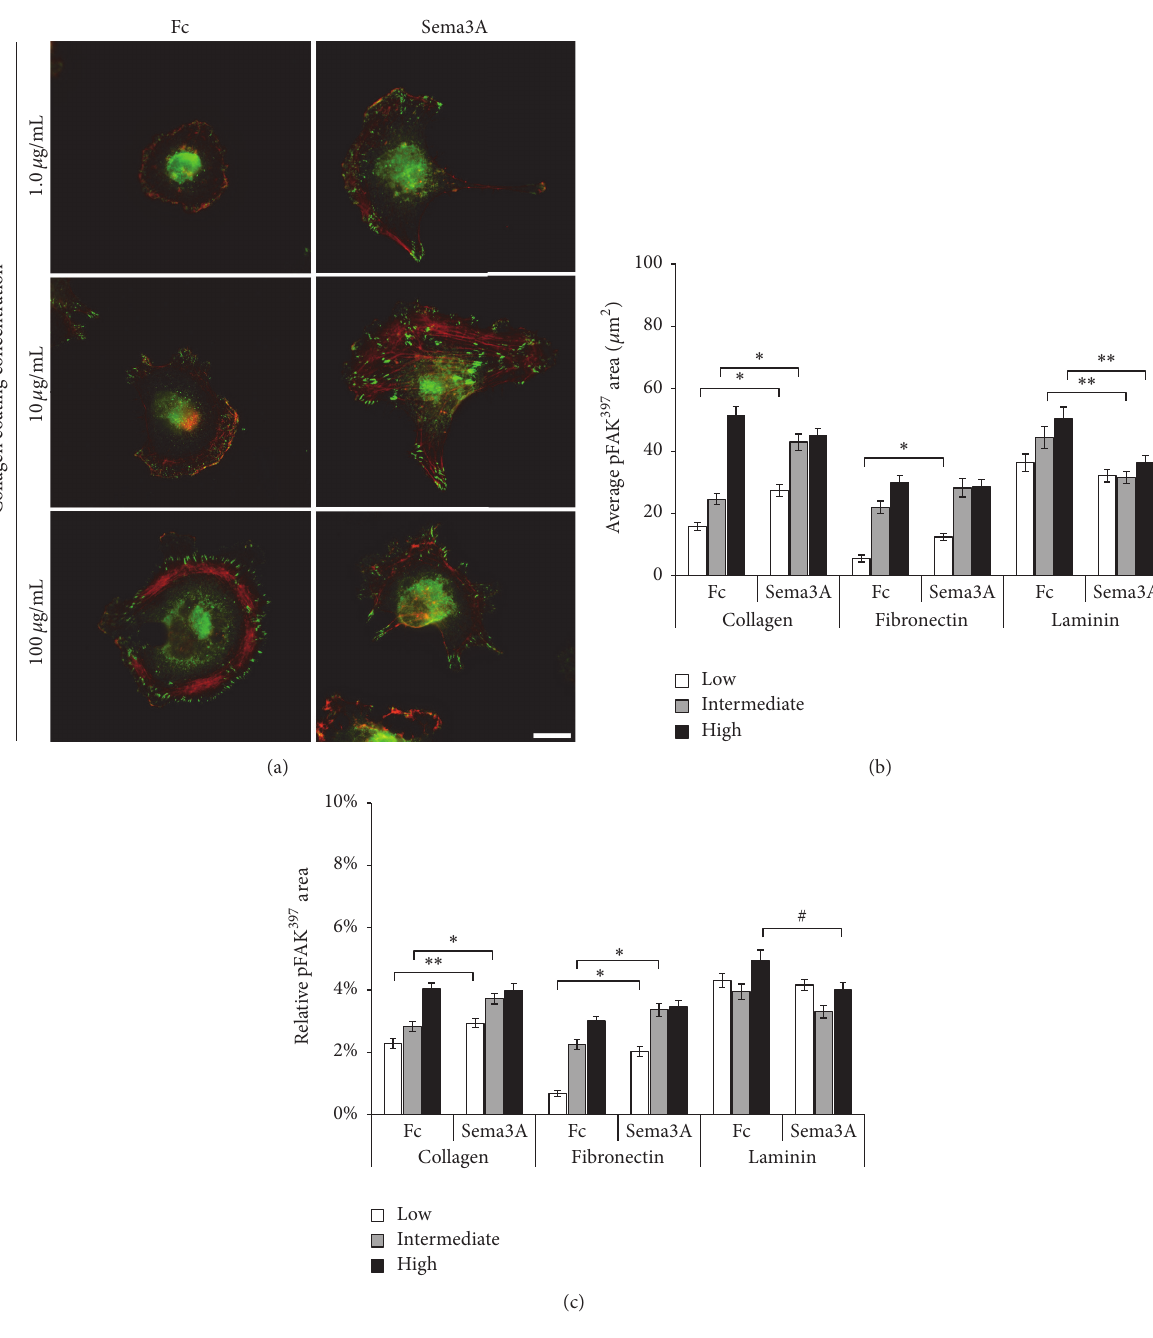
Figure 5: Sema3A increases pFAK 397 levels at focal adhesions in cells plated on collagen and fibronectin, but not laminin. (a) Representative images of cells grown on substrata coated with low, intermediate, and high concentrations of collagen. Indirect immunofluorescence of focal adhesions using an antibody for phosphorylated FAK 397 (green) and counterstained with phalloidin (red). Scale bar = 10 𝜇 m. (b) Sema3A increased the average total surface area of pFAK 397 by ∼ 74% on substrata coated with low and intermediate concentrations of collagen, while Sema3A produced an increase of 127% on substrata coated with low concentrations of fibronectin. pFAK 397 staining was not statistically different at high coating concentrations of collagen or fibronectin. Interestingly, Sema3A reduced the average total surface area of pFAK 397 by 11–29% on all coating concentrations of laminin. (c) Relative pFAK 397 area as analyzed by the average total surface area occupied by pFAK 397 normalized to total cell area as determined by TRITC-phalloidin. Data are presented as average ± SEM from a minimum of 50 cells for each condition. ∗ 𝑝 < 0.001 , ∗∗ 𝑝 < 0.005 , and # 𝑝 < 0.05 indicate statistical significance relative to IgG1 Fc control; two-sample 𝑡